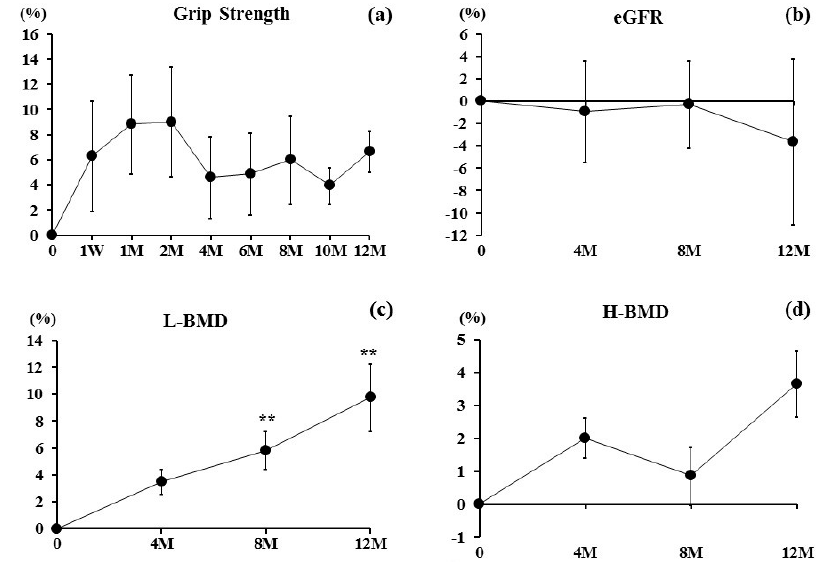
significant difference at one week or 1, 2, 4, 6, 8, 10, and 12 months compared with pretreatment.